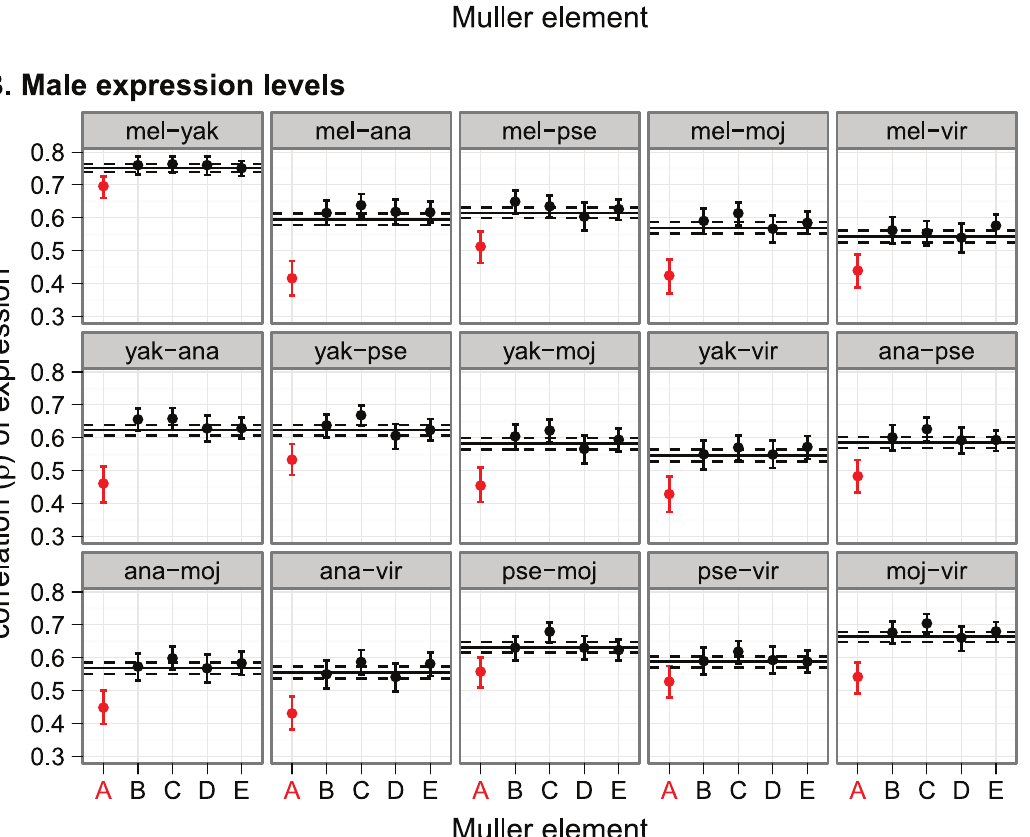
Figure 1. Faster-X evolution of gene expression. Pairwise correlations of gene expression are shown for genes on each chromosome arm, using expression measurements from (A) females or (B) males. In each graph, the solid horizontal line is the genome-wide correlation, and the dashed lines